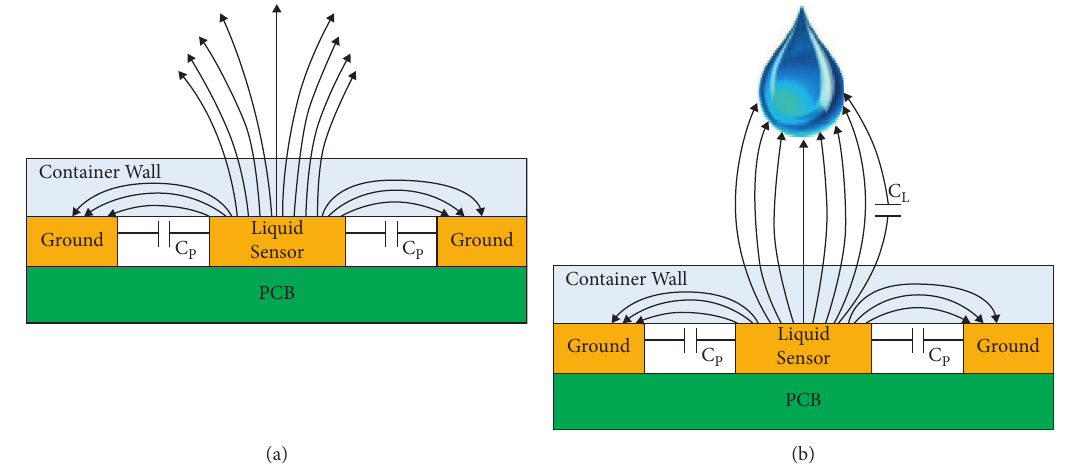
Figure 1: (a) Capacitive level sensor. (b) Extra capacitance once fluid approaches the sensor.